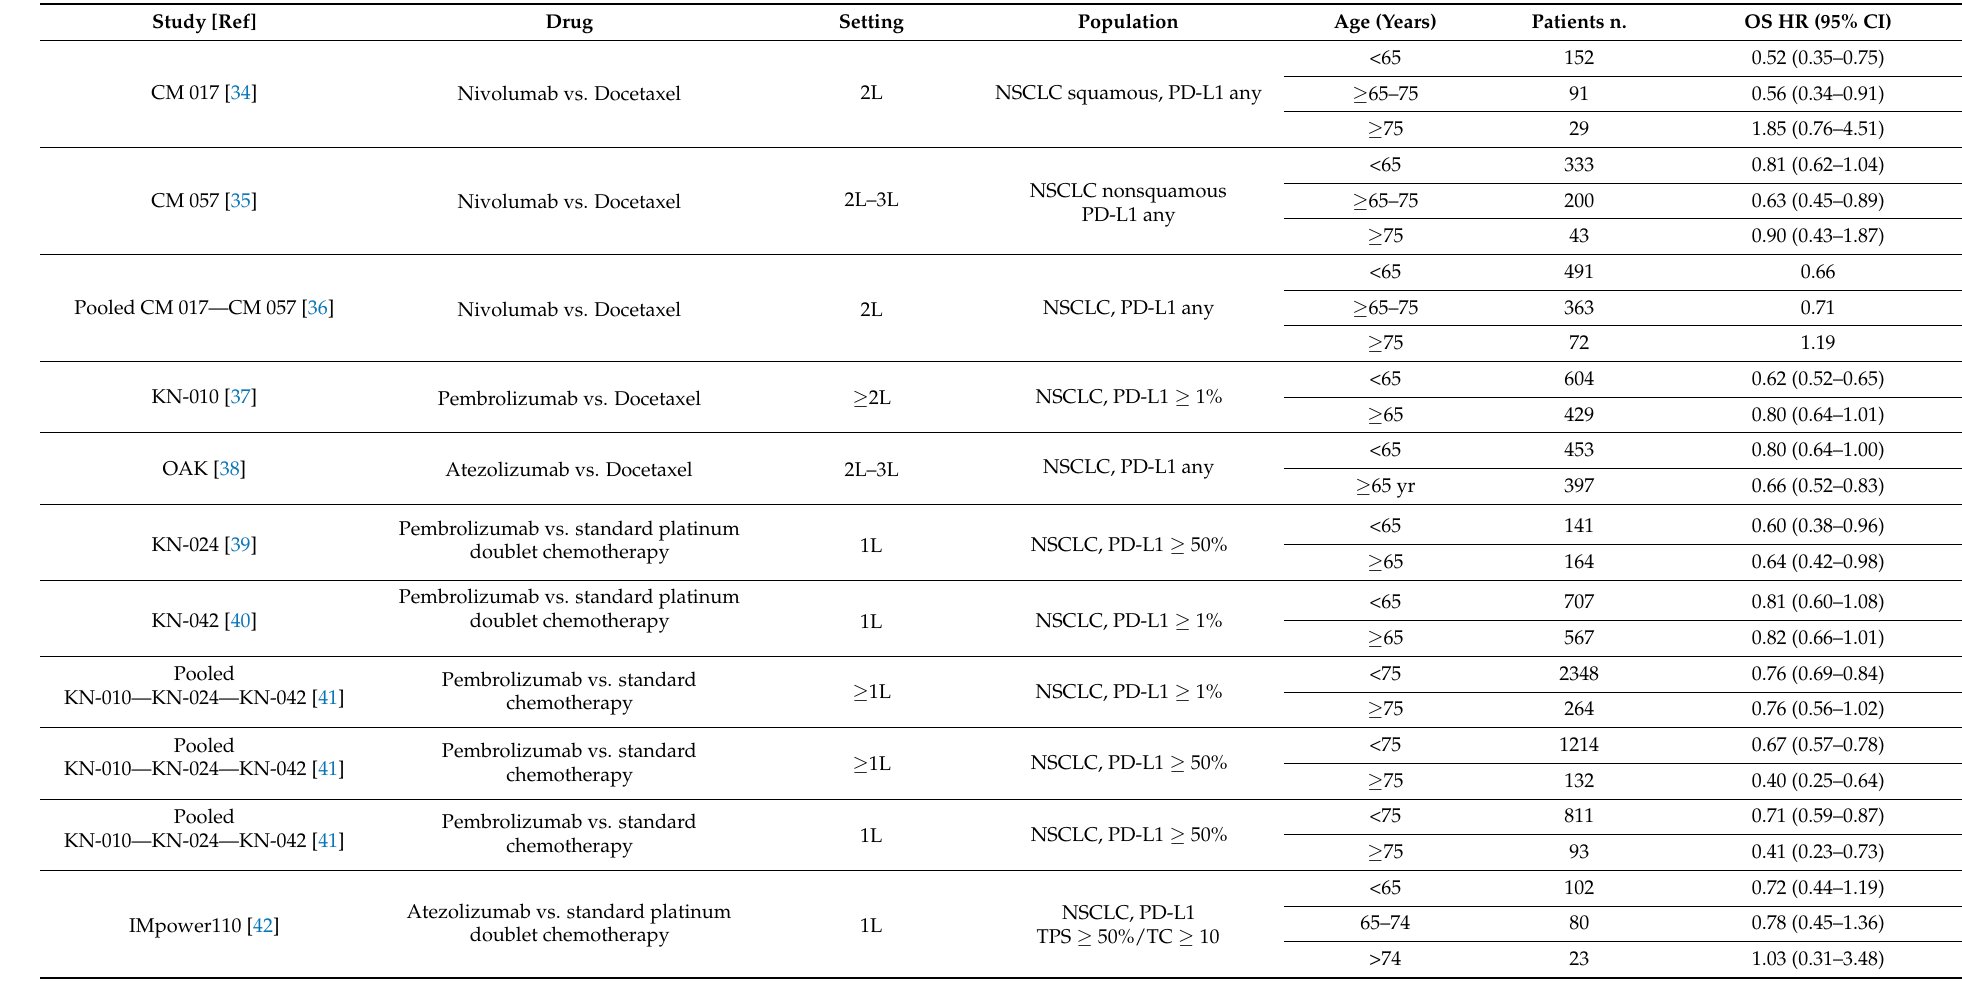
Table 1. Overall survival by age in clinical trials and pooled analyses investigating ICIs in advanced